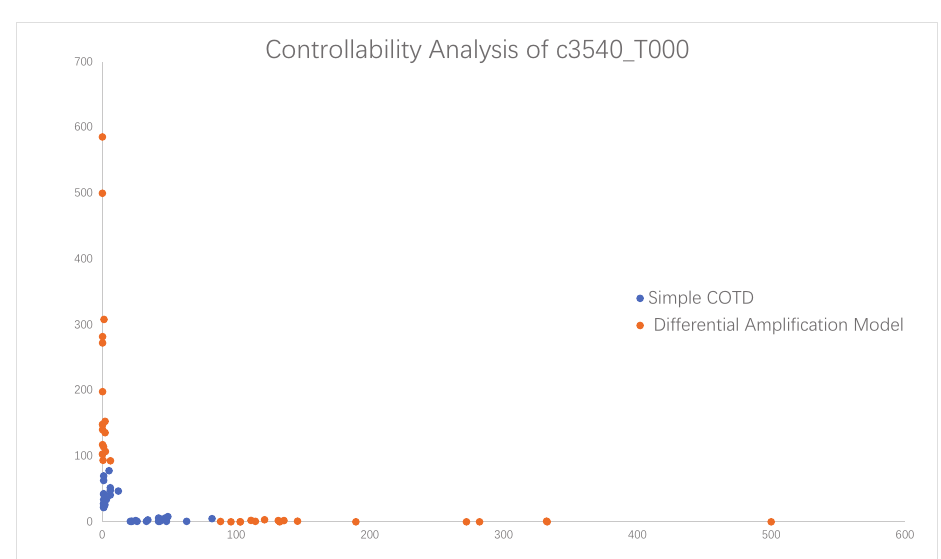
Figure 5. Controllability analysis of